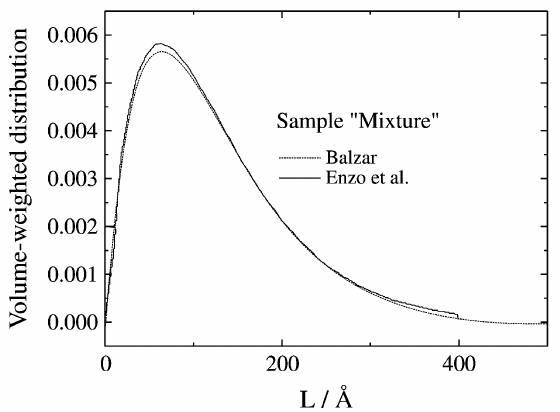
Figure 6. Comparison of the volume-weighted distributions determined through the Balzar and Enzo et al. methods for the "mixture"sample. These two methods resulted in similar behavior and do not show the bimodal distribution determined by Warren-Averbach method (Figure